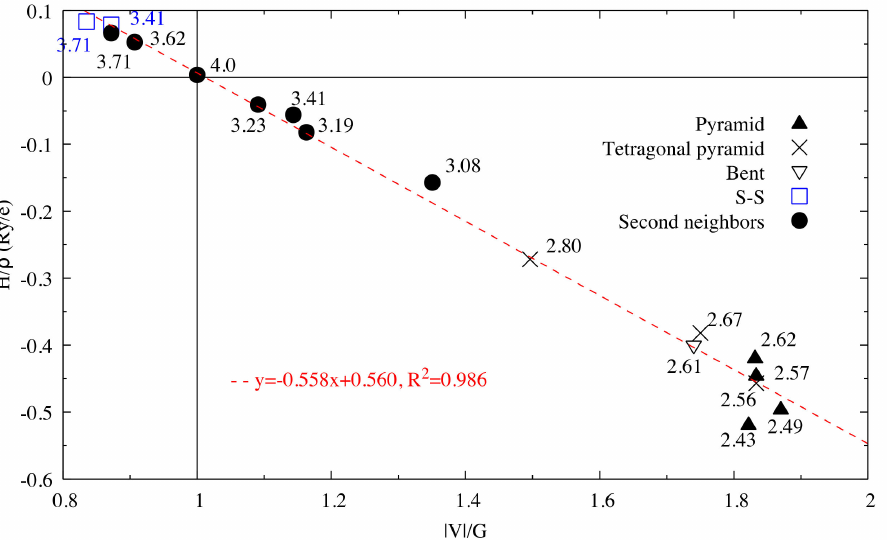
Figure 6. H b / ρ b vs. | V b | / G b for interactions in optimized Sb 2 S 3 Be 2 . The dash line corresponds to the fitting line for Sb–S interactions by least square